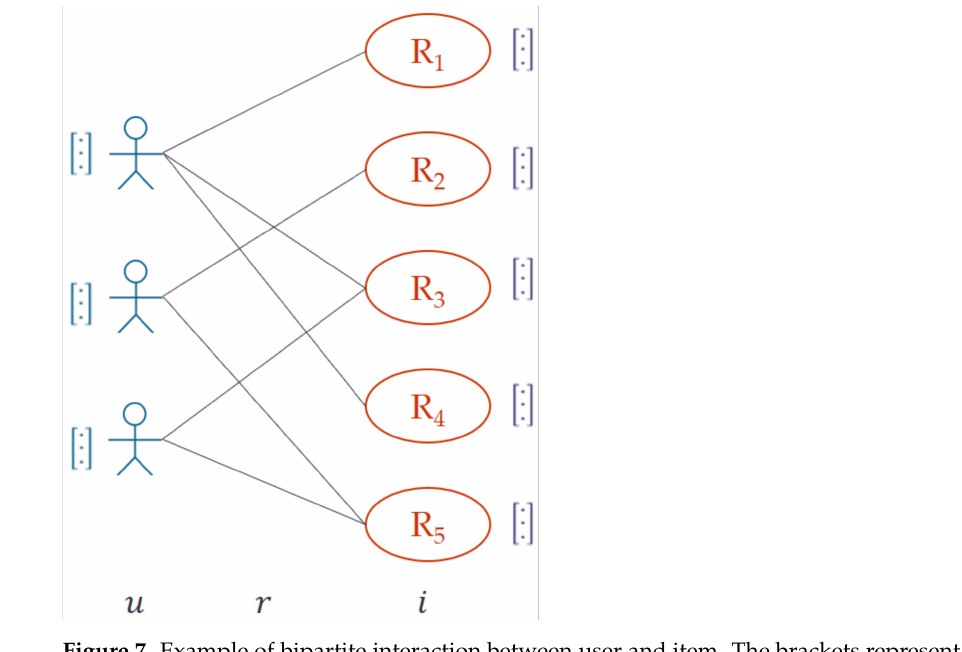
Figure 7. Example of bipartite interaction between user and item. The brackets represent the side features of users and